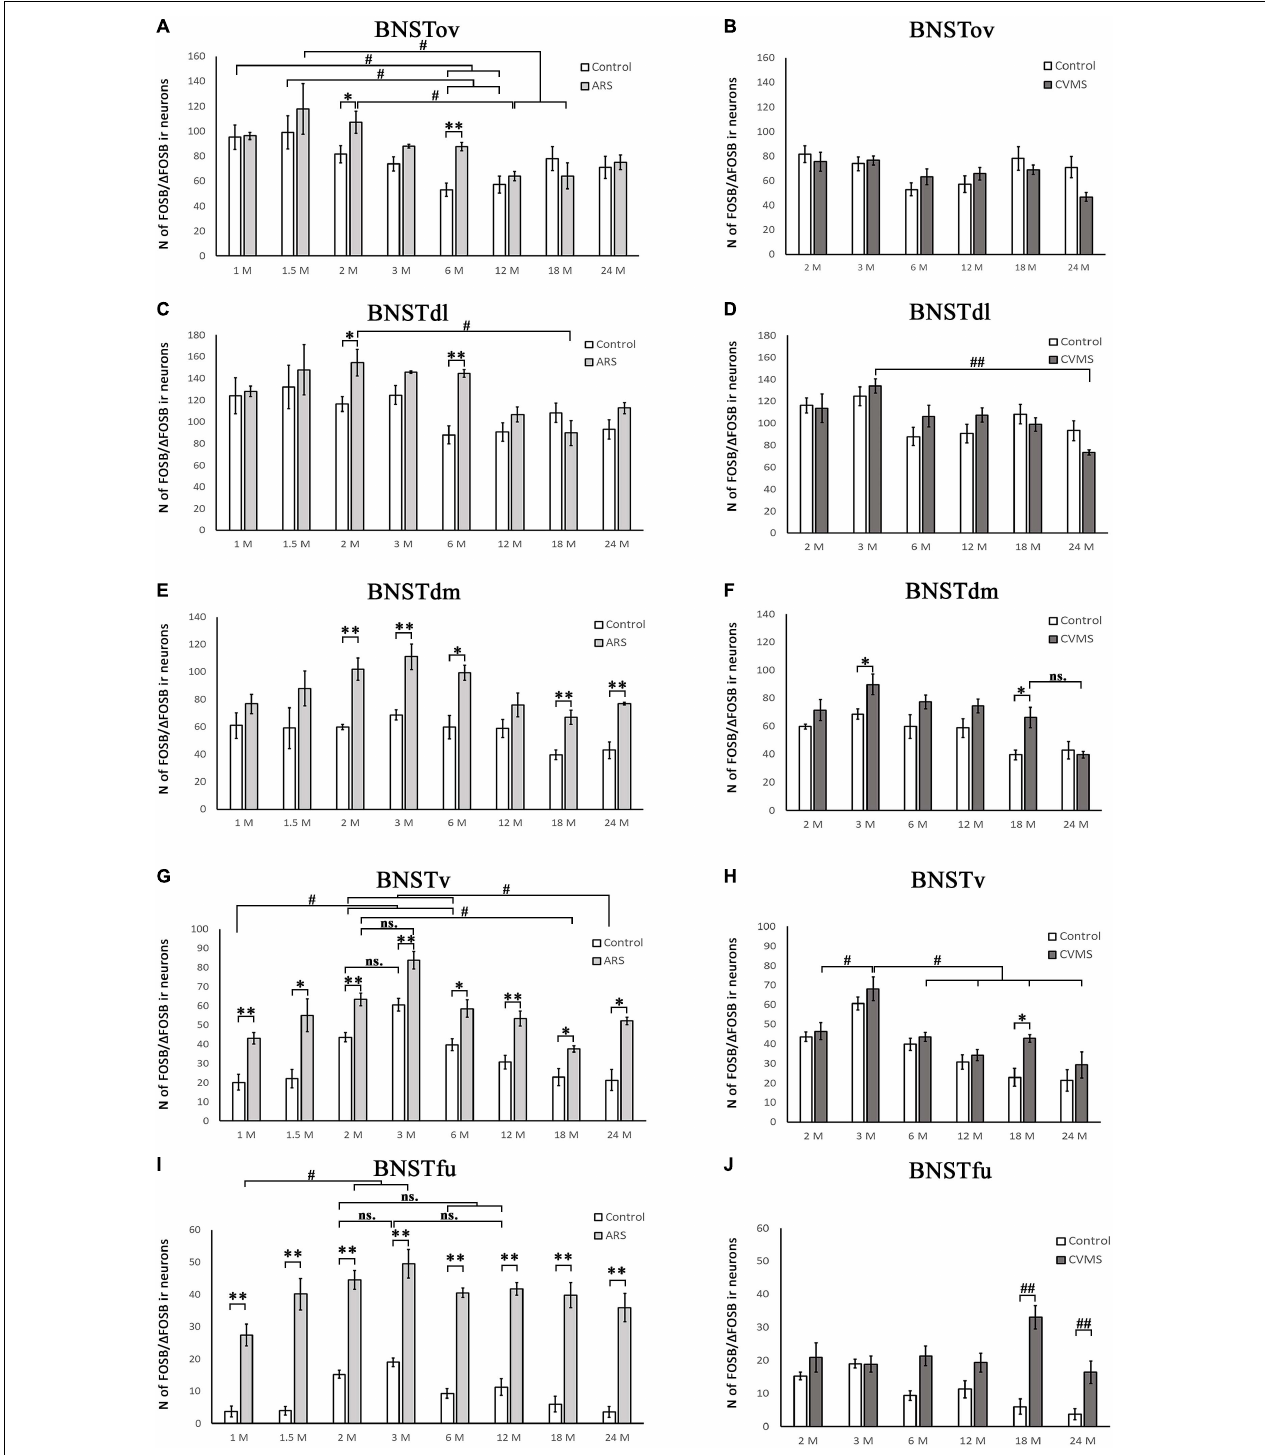
FIGURE 4 | Diagrams illustrating age-dependent FOSB/ (cid:49) FOSB immunoreactivity (IR) in the bed nucleus of the stria terminalis (BNST). The number of FOSB/ (cid:49) FOSB IR nuclei was compared among eight age groups in two models. Control vs. acute restraint stress (ARS) and control vs. chronic variable mild stress (CVMS) comparisons are shown in histograms (A,B) for the oval (BNSTov); (C,D) for dorsolateral (BNSTdl); (E,F) for dorsomedial (BNSTdm); (G,H) for ventral (BNSTv), and (I,J) for the fusiform (BNSTfu) subdivisions of the BNST. Open bars represent the control groups; light gray columns refer to ARS-exposed rats; dark gray columns indicate the CVMS-exposed animals ( N = 4–7). # p < 0.05, ## p < 0.01 (ns, insignificant), according to Tukey’s post-hoc test. ∗ p < 0.05, ∗∗ p < 0.01 according to t -tests. Representative images are shown in Figure 3 .